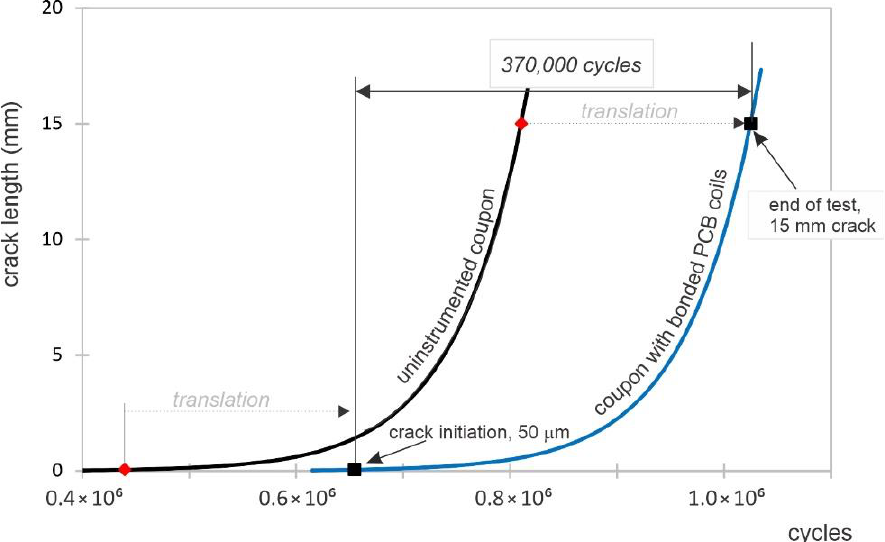
Figure 13. Estimation of number of cycles from crack initiation to the end of the test.